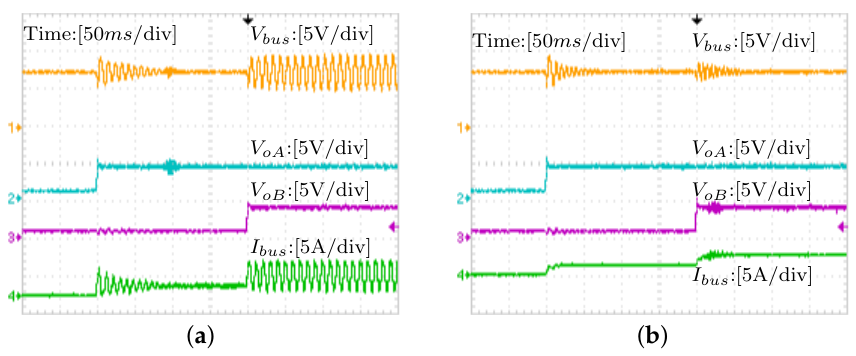
Figure 16. Experimental results of sequential switching of Load A and Load B : ( a ) without the proposed controller; and ( b ) with the proposed controller.